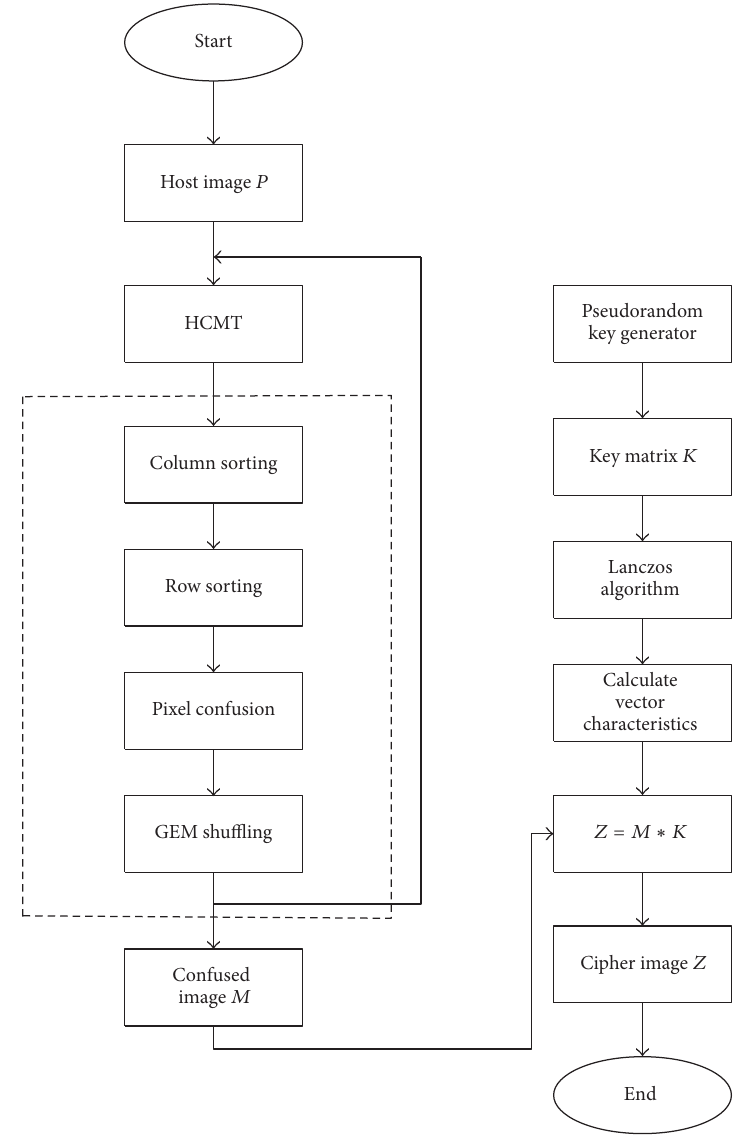
Figure 3: Proposed framework for image